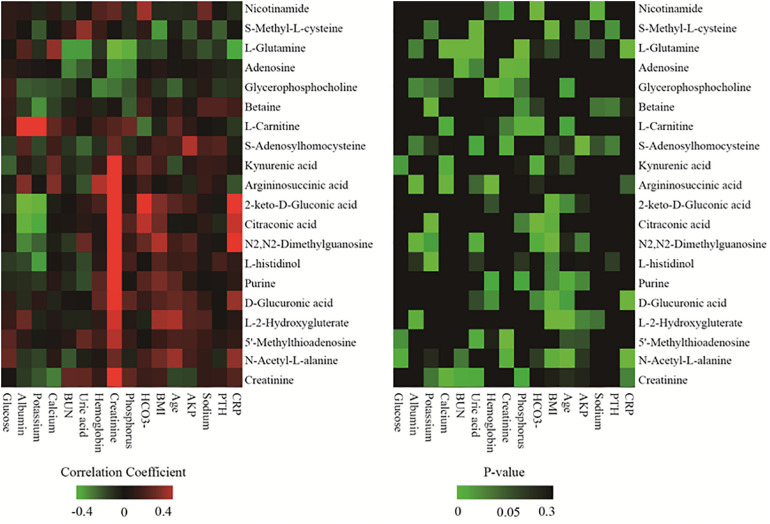
Heatmap of correlation analysis between 20 discriminating metabolites and various clinical parameters.